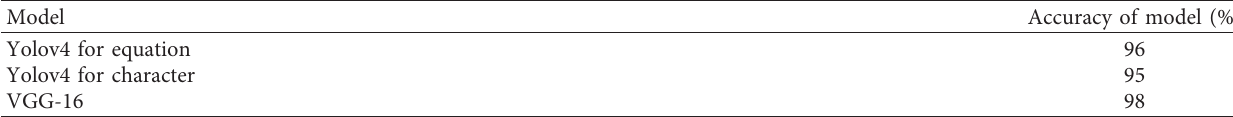
Table 3: Comparing accuracy of model after training.